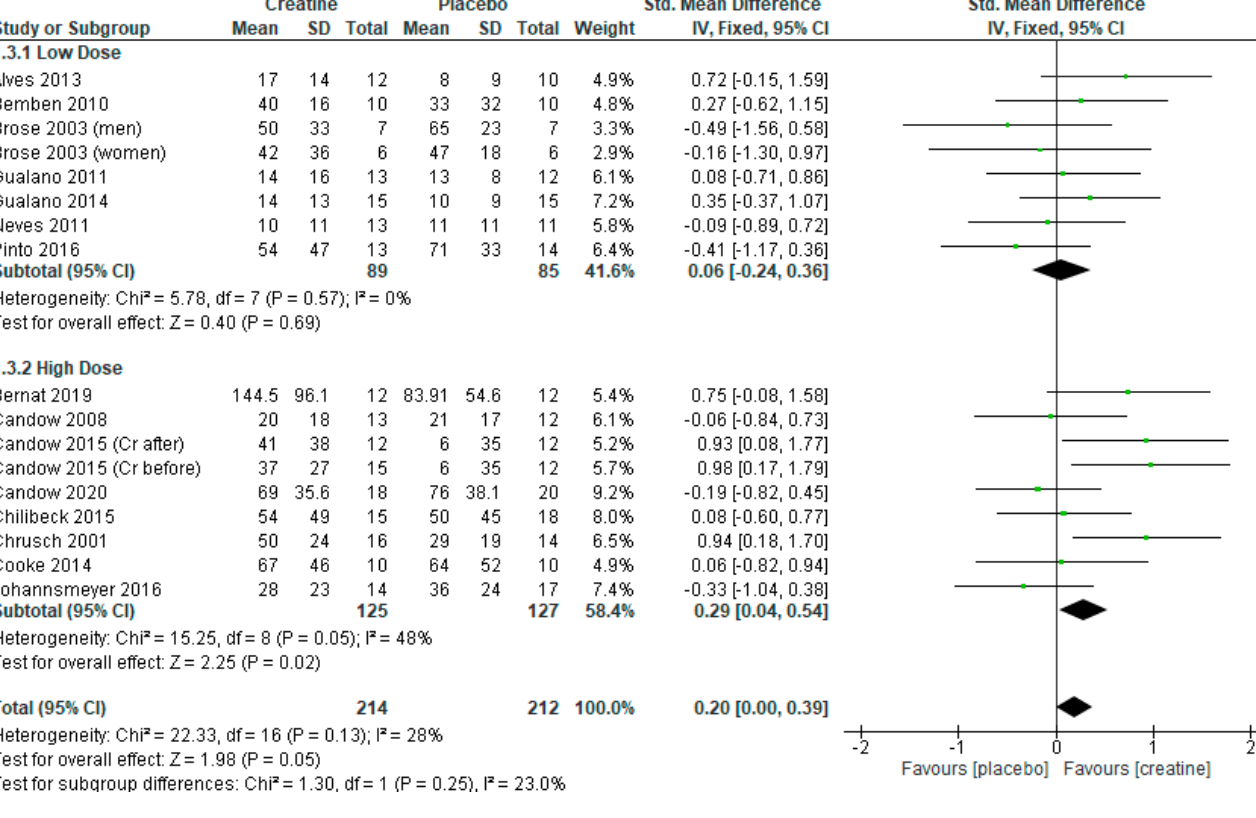
Figure 4. Forest plot of studies on leg press strength.